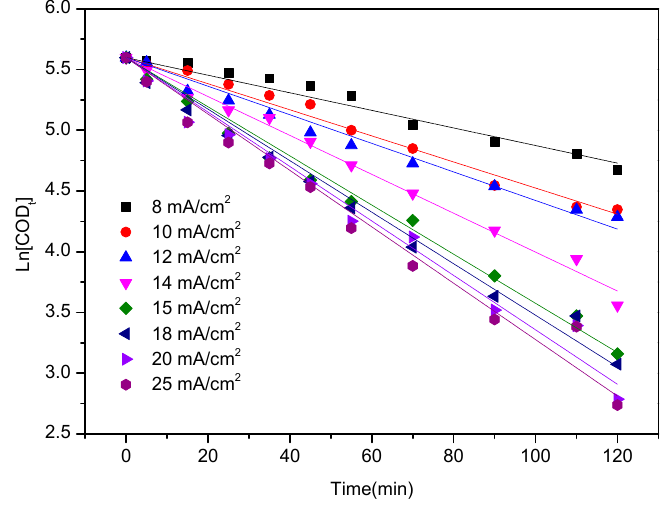
Figure 2. Flowchart of a backpropagation artificial neural network (BP–ANN) combined with particle swarm optimization (PSO).